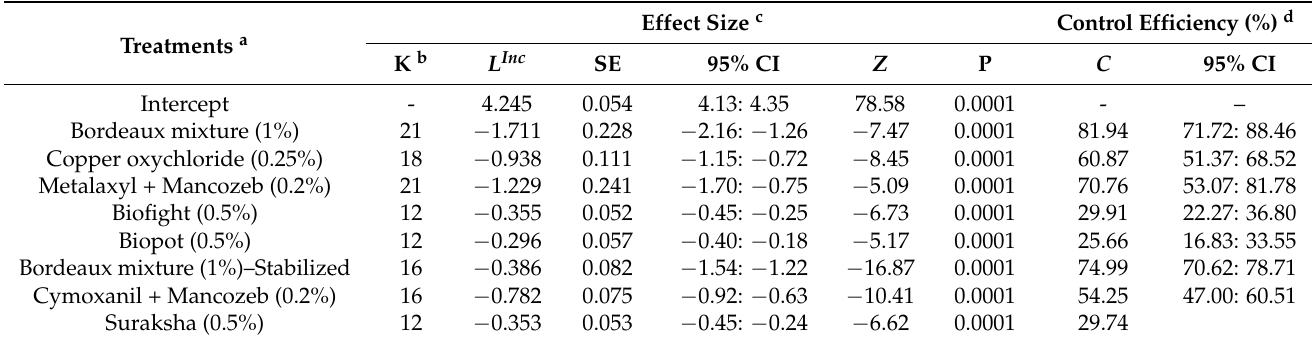
The network meta-analysis model fitted the data collected from the field trials carried out under multi-location conditions in India. a Active ingredients of treatments used against FRD in arecanut under field conditions. b The number of trials selected for each specific treatment with untreated controls. c Mean logarithmic rate ratio ( L Inc ) for the average effect of each treatment on FRD compared to the untreated check standard error (SE) of L Inc and 95% confidence interval (CI) containing L Inc ; Z (standard normal) statistic from the network meta-analytical model; p = probability value (level of significance). d Average percentage of control efficiency ( C ) and 95% CI containing C ; Test for Residual Heterogeneity; QE (df = 52) = 7689.7531, p -value < 0.0001; Test of Moderators (coefficients 2:9);